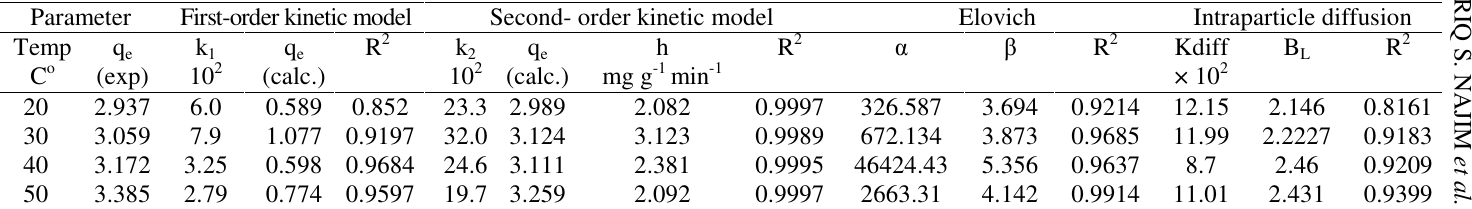
Table 4 . Comparison of the first order, second order, Elovich and intraparticle diffusion rate constants and calculated and experimental